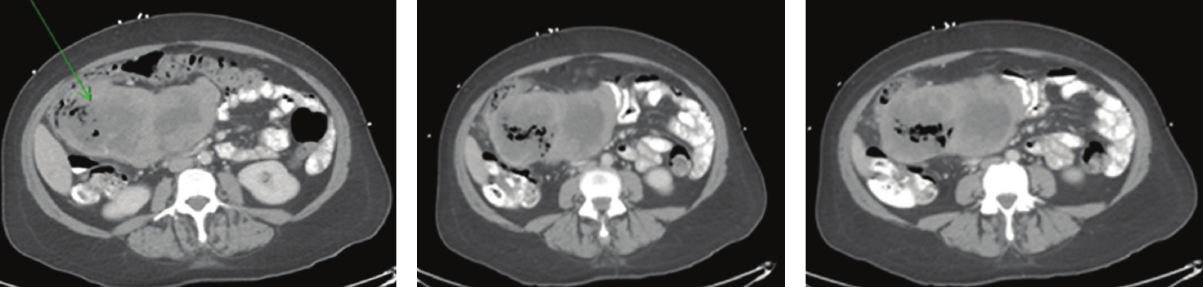
Figure 1: Computed tomography of the abdomen showing a retroperitoneal mesenteric mass with fistulization (communication) into the right colon.